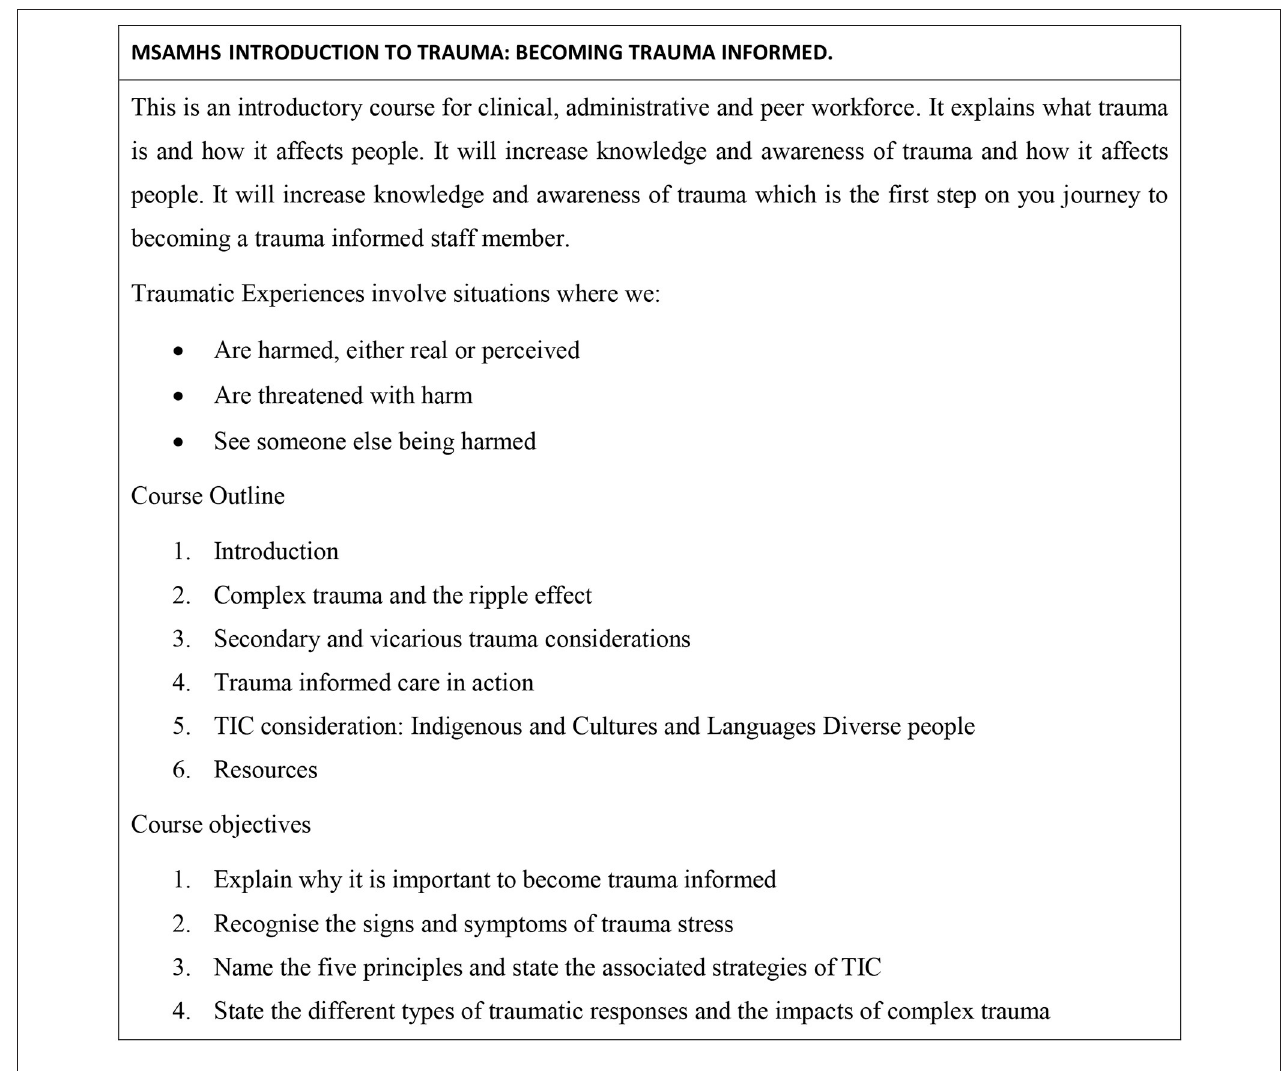
people with a history of homelessness (Transitional Housing Team), two community-based outreach teams (Mobile Intensive Rehabilitation Teams), an Early Psychosis team and three residential rehabilitation units (Community Care Units) (see Table 1 ). The senior leadership across the rehabilitation service identified the implementation of TIC as a quality improvement activity. The implementation experience reported in this paper covered the period 15/11/2019 to 2/4/2021. This period was inclusive of unanticipated disruptions in service activity due